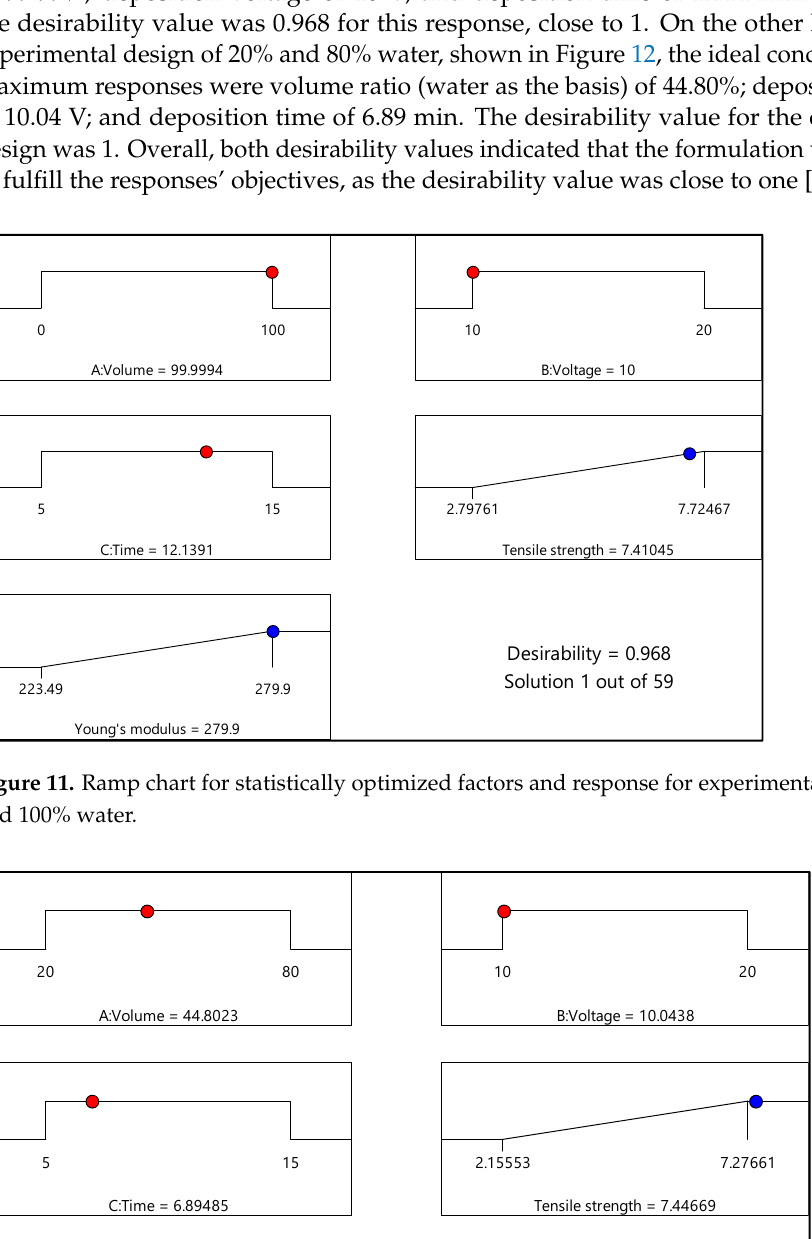
Table 14. Constraints for optimization for 20% and 80% experimental water design.